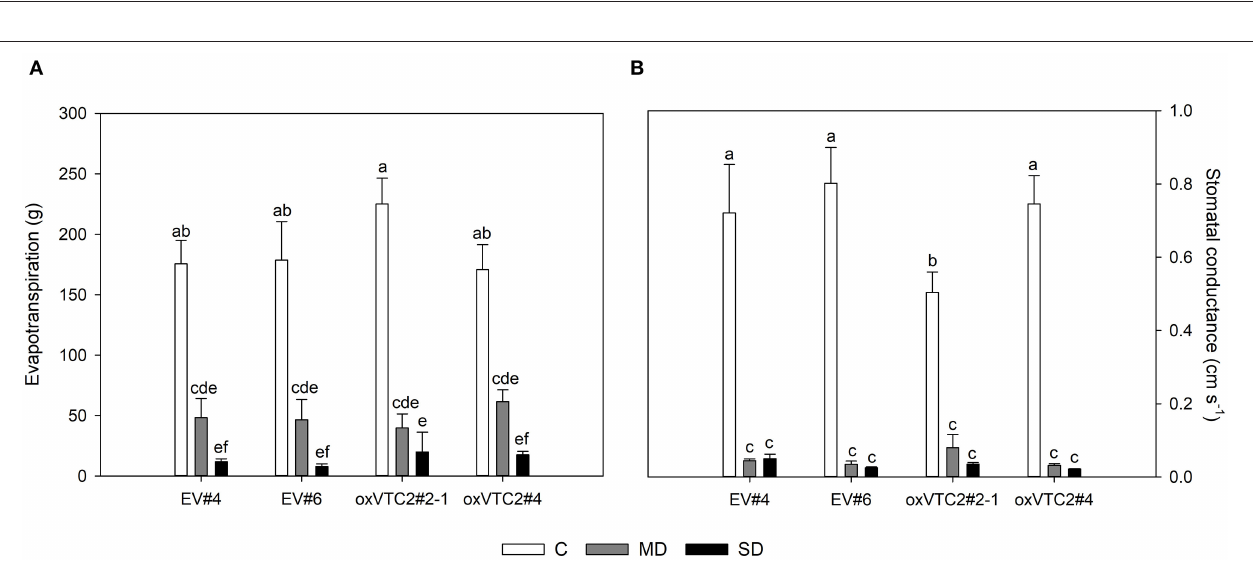
FIGURE 3 | Effects of progressive drought stress on leaf (A) and nodule (B) water potentials in M. truncatula empty vector (EV) and oxVTC2 plants under well-watered control (C), mild drought (MD), and severe drought (SD) conditions. Values represent the average ± SE ( n = 5 biological replicates). Mean values represented by the same letter do not differ statistically ( p ≤ 0.05 ANOVA test).